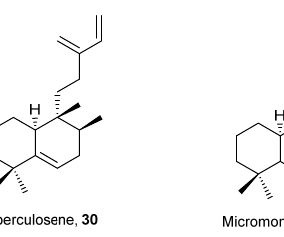
Table 4. Natural sources, activities of halimanes from bacteria. Bacterial Halimanes